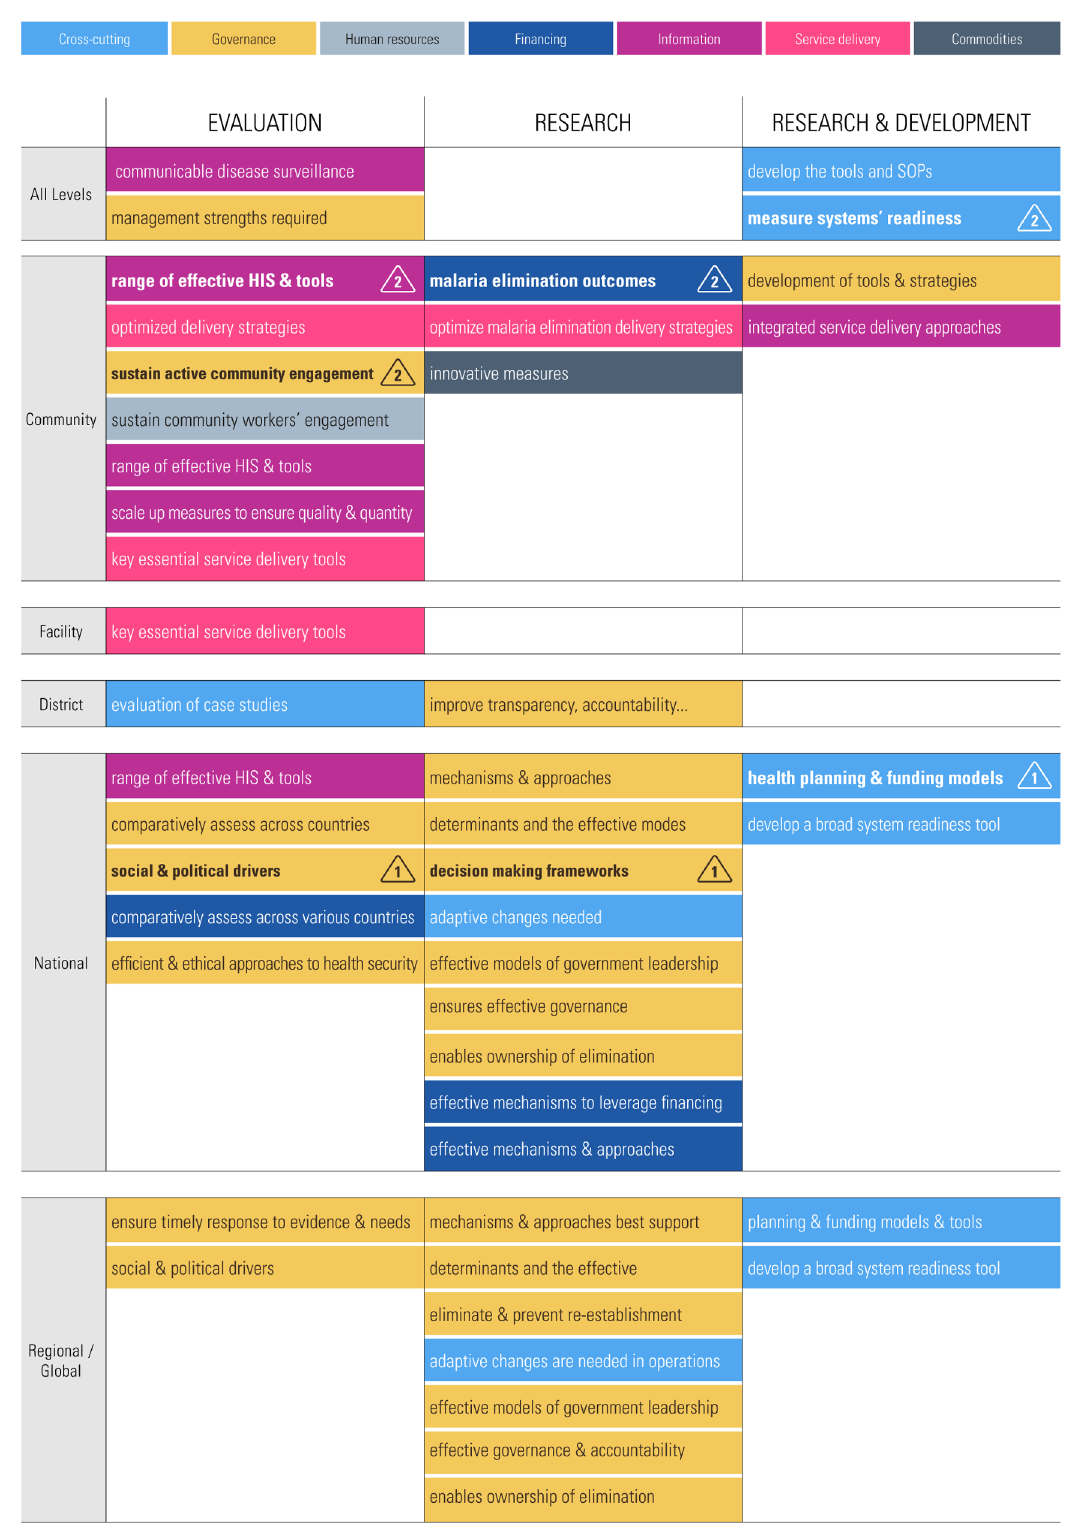
Fig 3. Overview of health systems and policy researchportfolio. HIS, health information system; SOP, standard operatingprocedure.